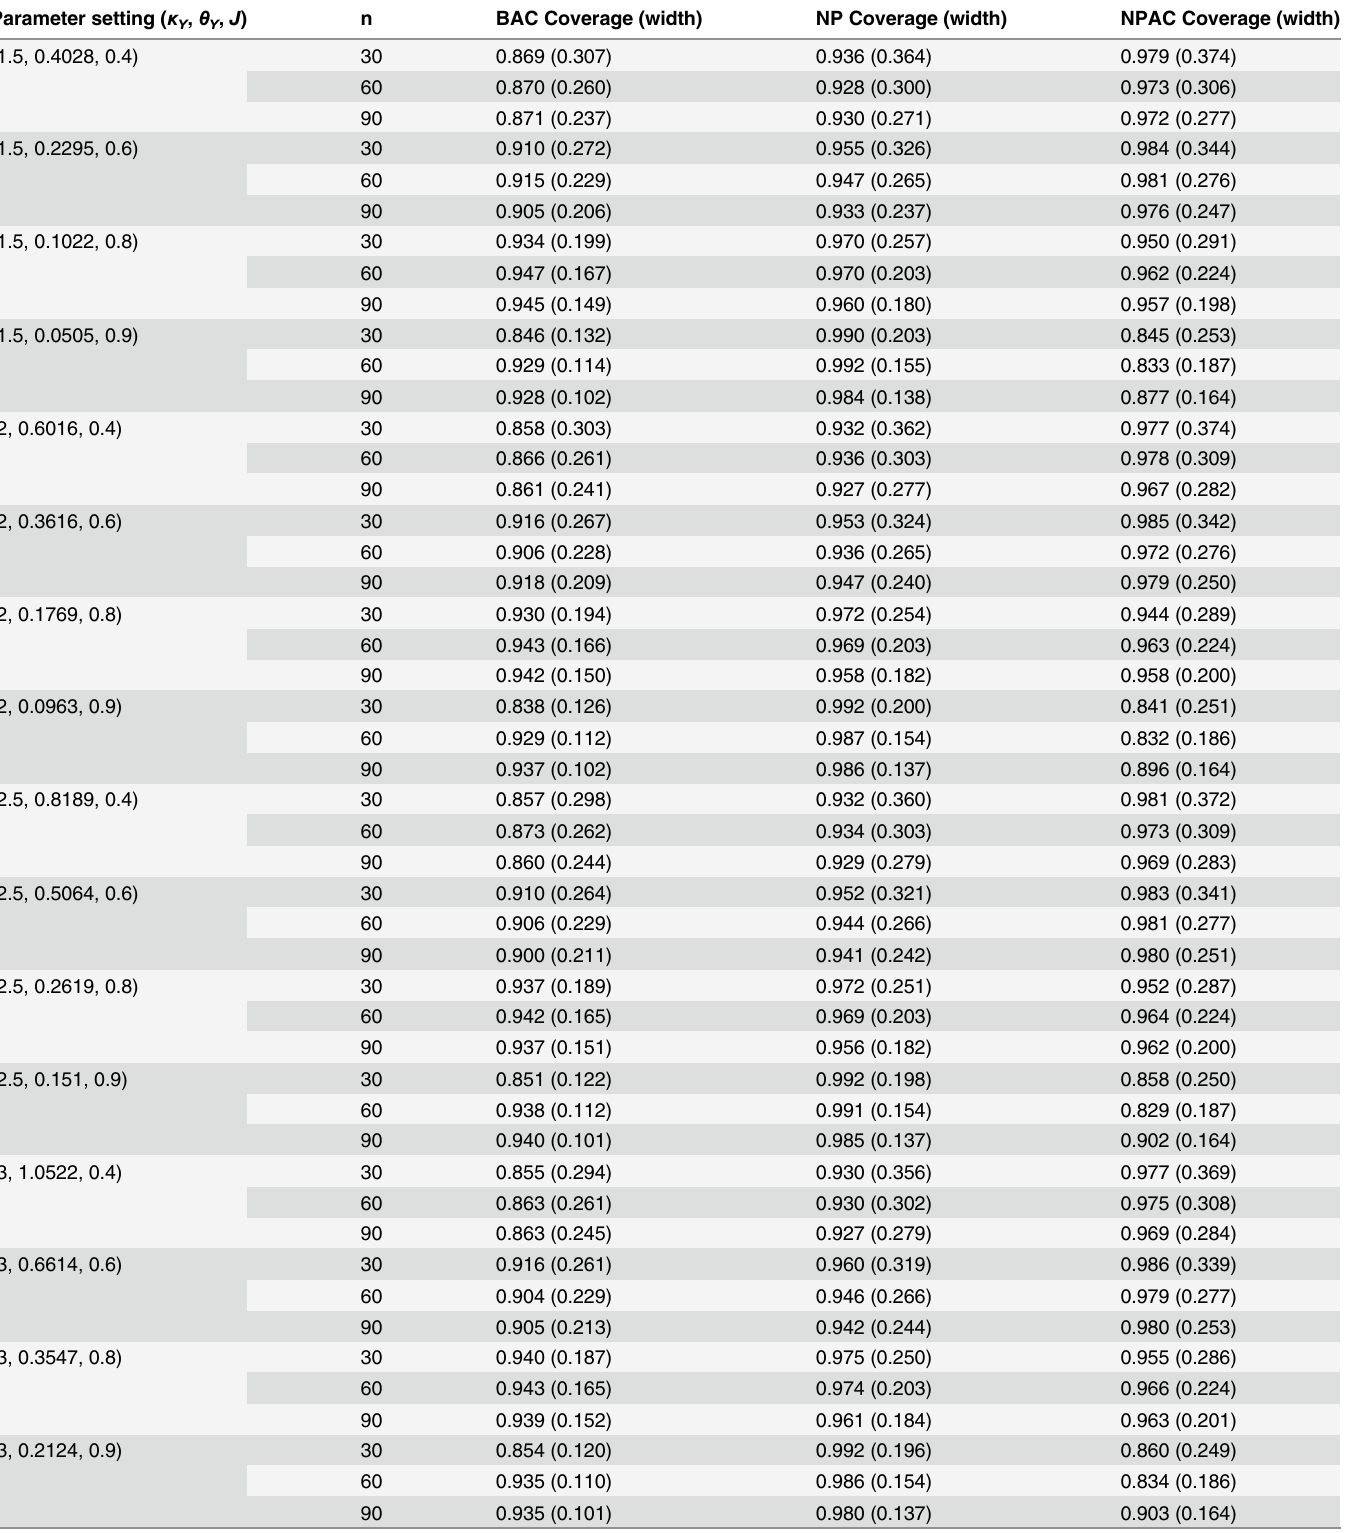
Table 7. Gamma distributions: coverage probabilities and average widths when m = 60 in the non-diseased group at the 95% nominal